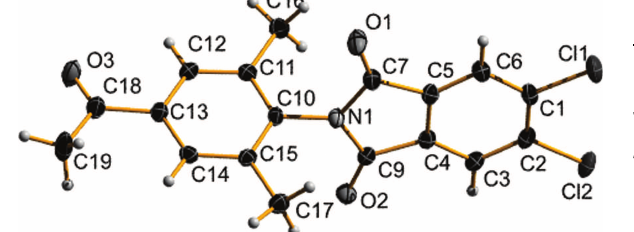
Table 1: Data collection and handling.